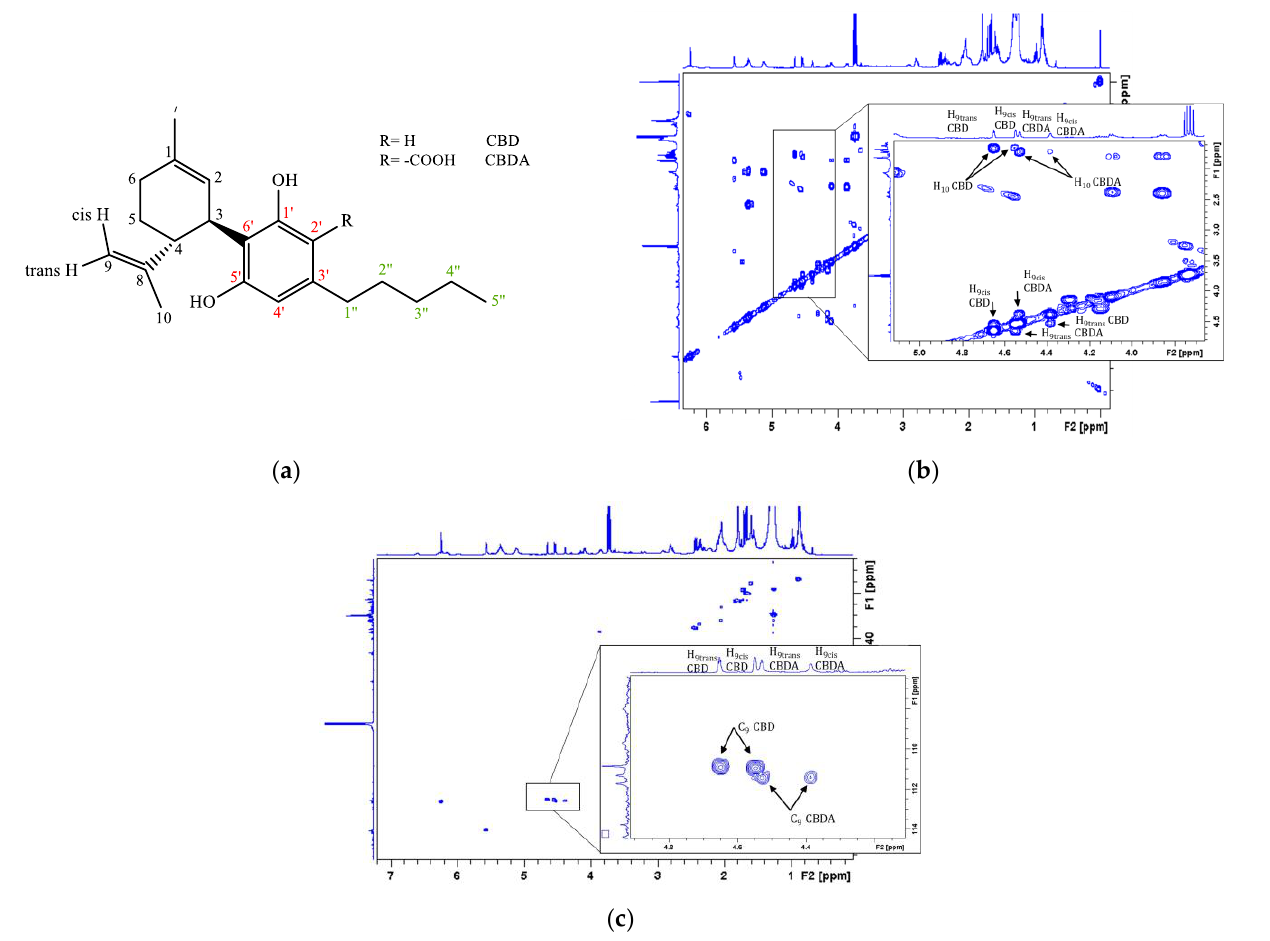
Figure 6. ( a ) Structure of CBD and CBDA reported together with atom numbering adopted; ( b ) 500 MHz 1 H COSY spectrum; and ( c ) 1 H- 13 C HMQC NMR spectrum of inflorescence ethanolic extract sample of Tiborszallasi , a variety dissolved in CDCl 3 and recorded at 298K.